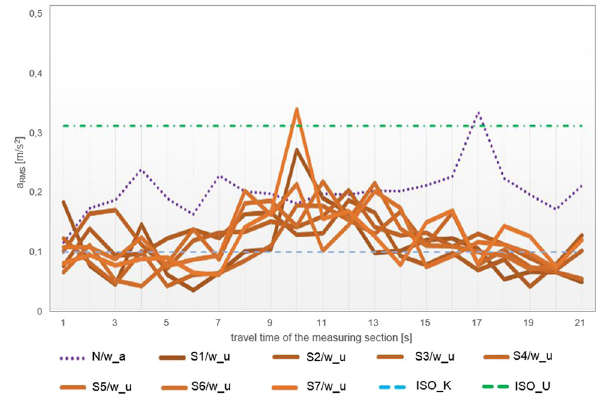
Figure 9: Characteristics of changes in the acceleration of vibrations a ( m/s 2 ) over time ( 8 Hz fi ltration, “ Z ” direction ) for passages on RMS